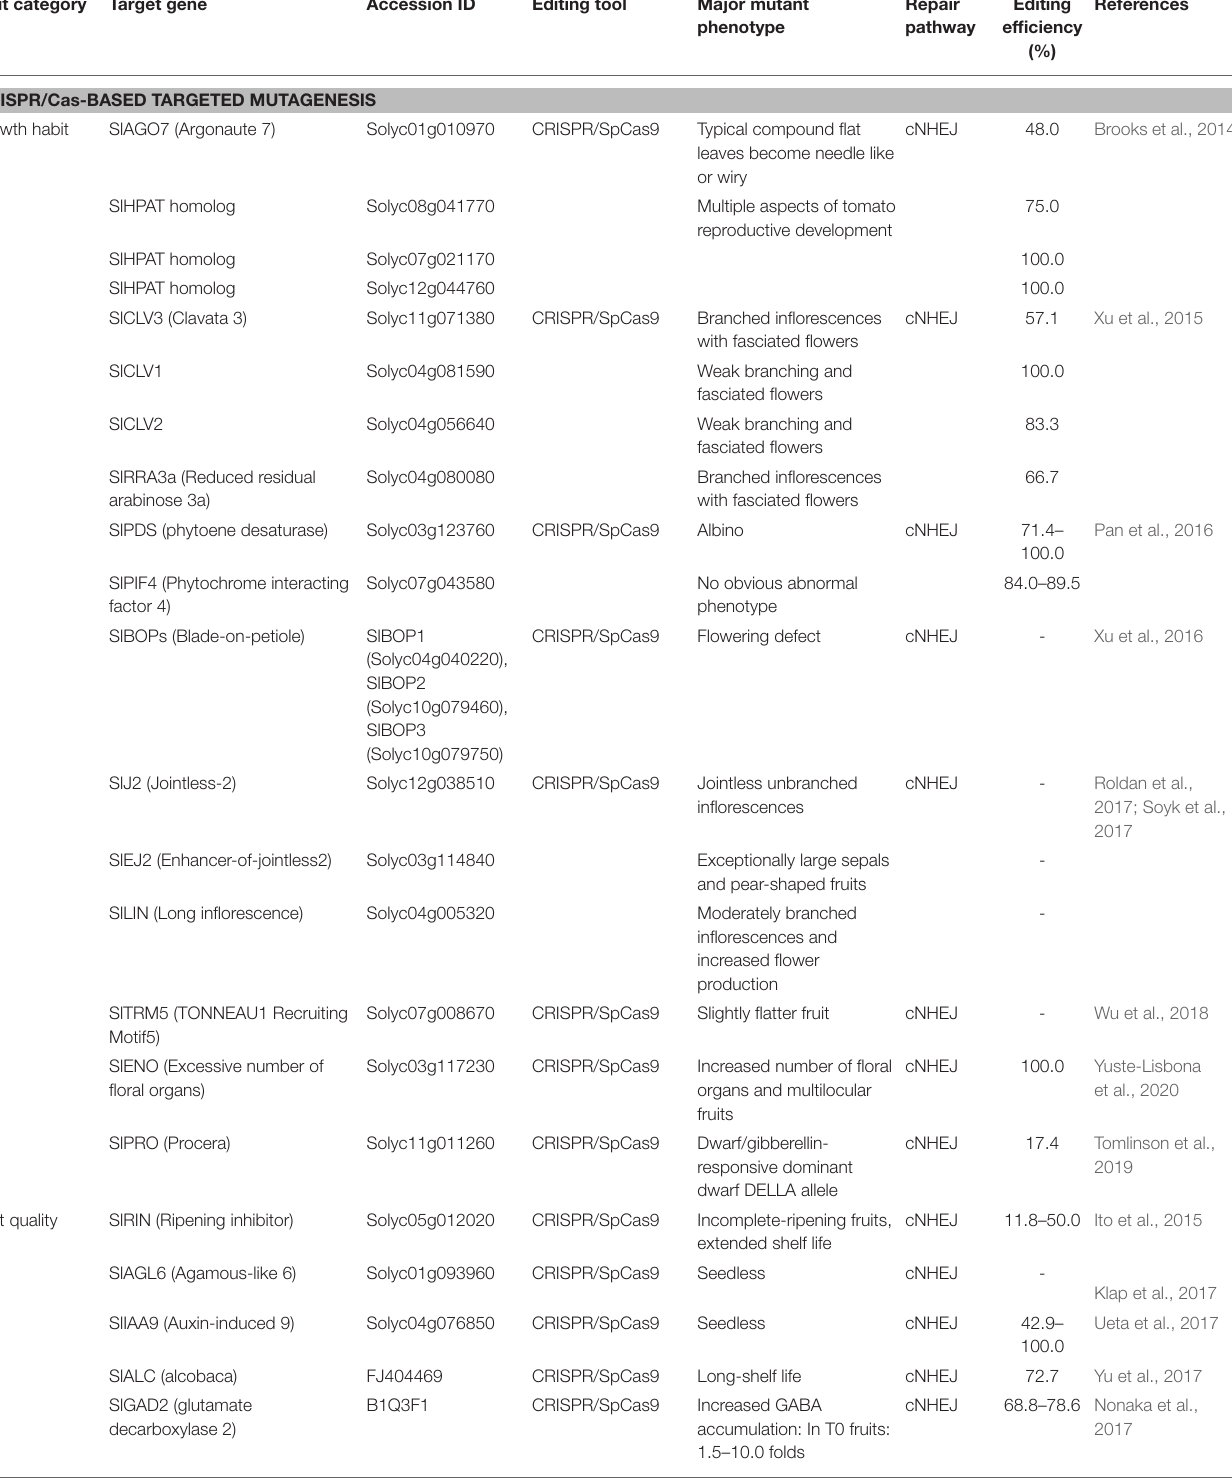
TABLE 1 | Precision genome editing in tomato using CRISPR/Cas